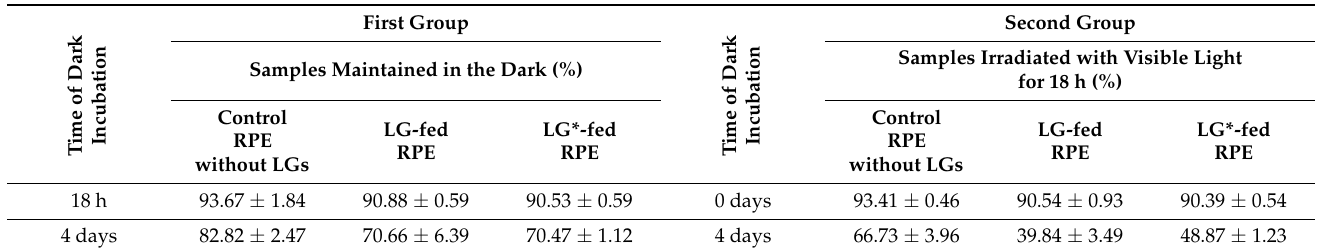
Table 1. Comparative flow cytofluorimetry analysis of cell viability when incubating RPE samples in the dark or after irradiation of RPE samples with visible